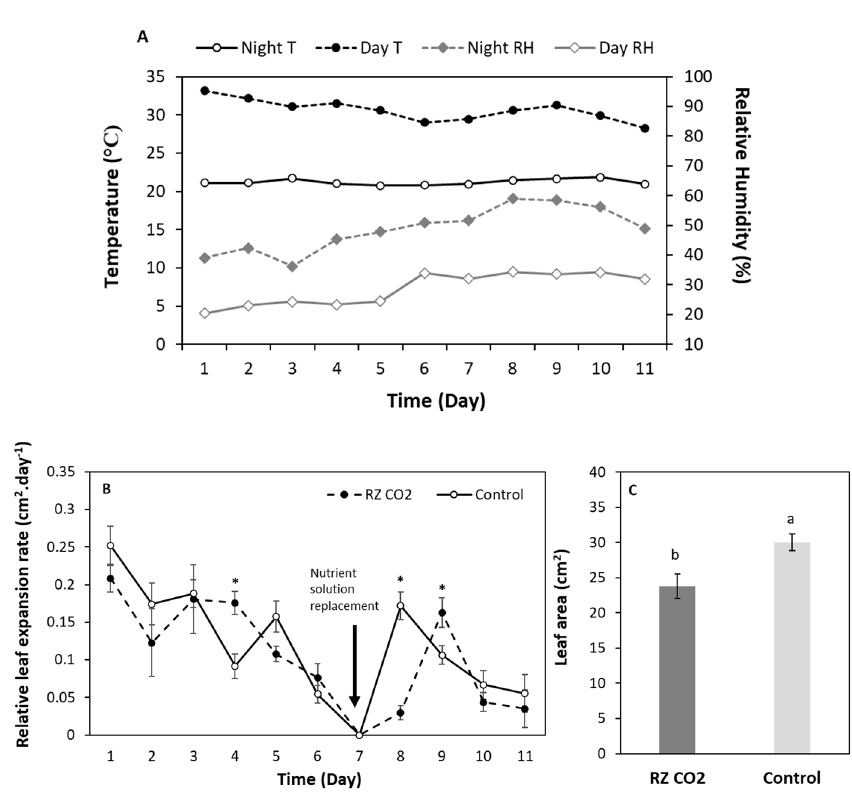
Figure 3. Night / day temperature (T) and relative humidity (RH) variation throughout the measurements ( A ). The daily pepper relative leaf expansion rate ( B ) and final leaf area ( C ) in plants exposed to high RZ CO 2 and ambient RZ CO 2 in plants exposed to high RZ CO 2 and ambient RZ CO 2 . Bars are the mean ± SE of eight replicates. Asterisks and di ff erent letters indicate significant ( p < 0.05) di ff erences between treatments.